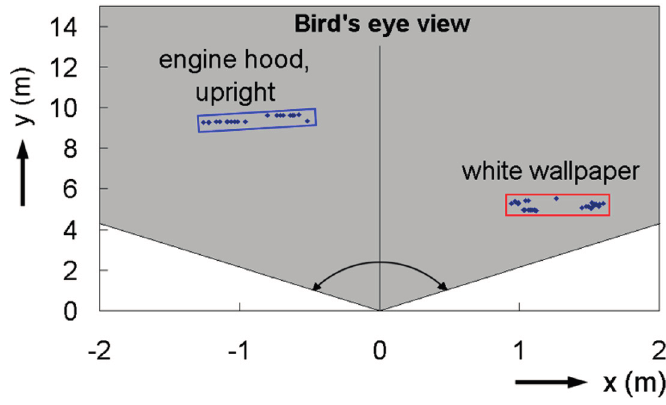
Figure 16. Point clouds detected by the microscanner system from objects at different angles and distances. The angular range is indicated. Reprinted with permission from [65], copyright 2006 IOS